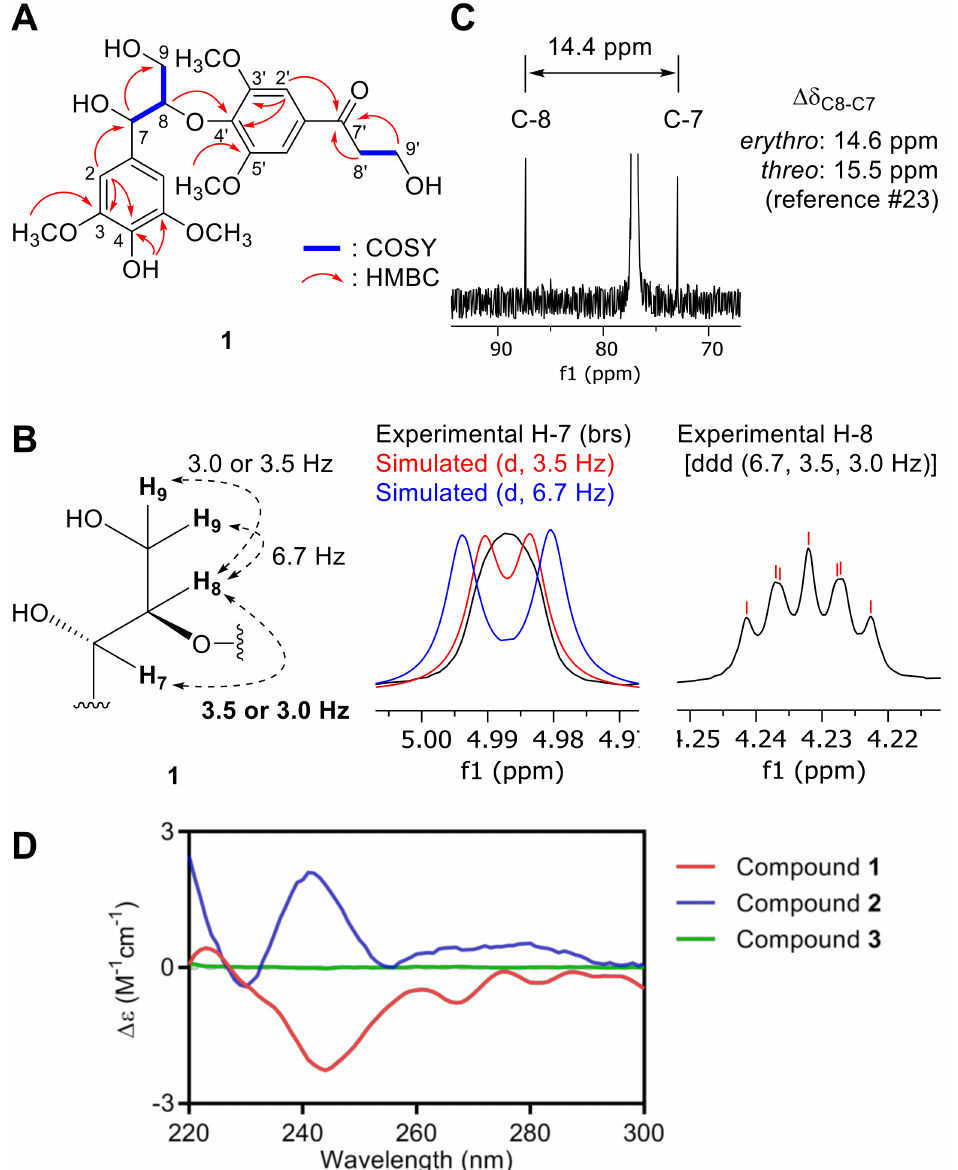
Figure 2. Structure elucidation of 1–3 . ( A ) Key COSY and HMBC correlations of 1 . ( B ) Coupling constants values among H-7, H-8, and H-9 (left) deduced by analysis of 1 H NMR peaks of H-7 (middle) and H-8 (right). ( C ) Zoomed-in 13 C NMR spectra of 1 for C-7 and C-8. ( D ) ECD spectra of 1–3 . The negative or positive Cotton effect around 240–245 nm indicated the 8 R - or 8 S -configuration,